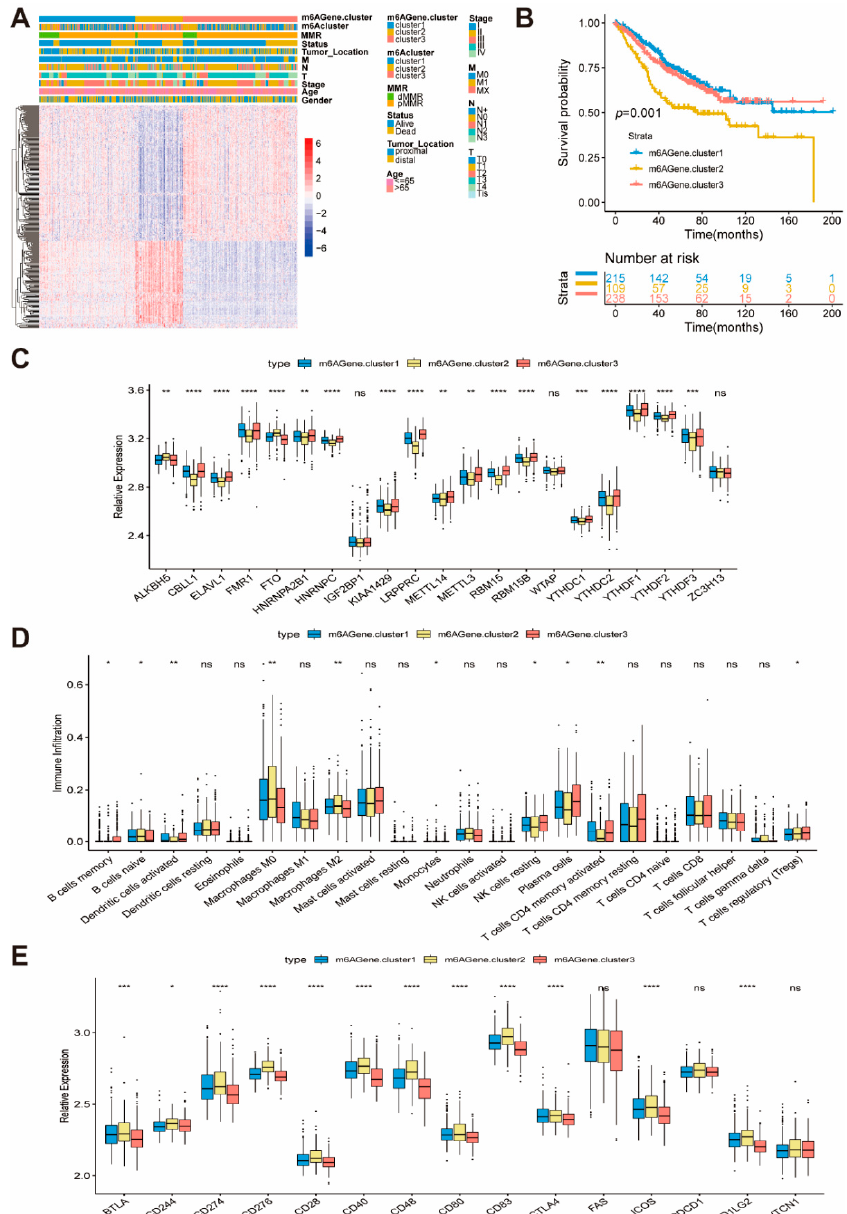
Figure 4. Construction of m6A phenotype-related genes and function. ( A ) Unsupervised clustering of overlapping m6A phenotype-related genes in GSE39582 to classify patients into different genomic subtypes, termed m6AGene.cluster1/2/3, respectively. The m6AGene.cluster, m6Acluster, MMR, status, tumor_location, M, N, T, stage, age and gender were used as patient annotations. ( B ) Kaplan-Meier curves indicated m6A modification genomic phenotype were markedly related to overall of 562 patients in GSE39582, of which 215 cases were in m6Agene.cluster1, 109 cases were in m6Agene.cluster2, 238 cases were in m6Agene.cluster3. ( p = 0.001). ( C ) The expression of 21 m6A regulators in the three gene clusters. The upper and lower ends of the boxes represent the interquartile range of values. The lines in the boxes represent the median value, and the black dots show the outliers. The asterisks represent the statistical p -value (* p < 0.05, ** p < 0.01, *** p < 0.001, **** p < 0.0001). ( D ) The abundance of each immune cells in the three gene clusters. The upper and lower ends of the boxes represent the interquartile range of values. The lines in the boxes represent the median value, and the black dots show the outliers. The asterisks represent the statistical p -value (* p < 0.05, ** p < 0.01, *** p < 0.001, **** p < 0.0001). ( E ) The expression of checkpoint genes in the three gene clusters. The upper and lower ends of the boxes represent the interquartile range of values. The lines in the boxes represent the median value, and the black dots show the outliers. The asterisks represent the statistical p -value (* p < 0.05, ** p < 0.01, *** p < 0.001, **** p <